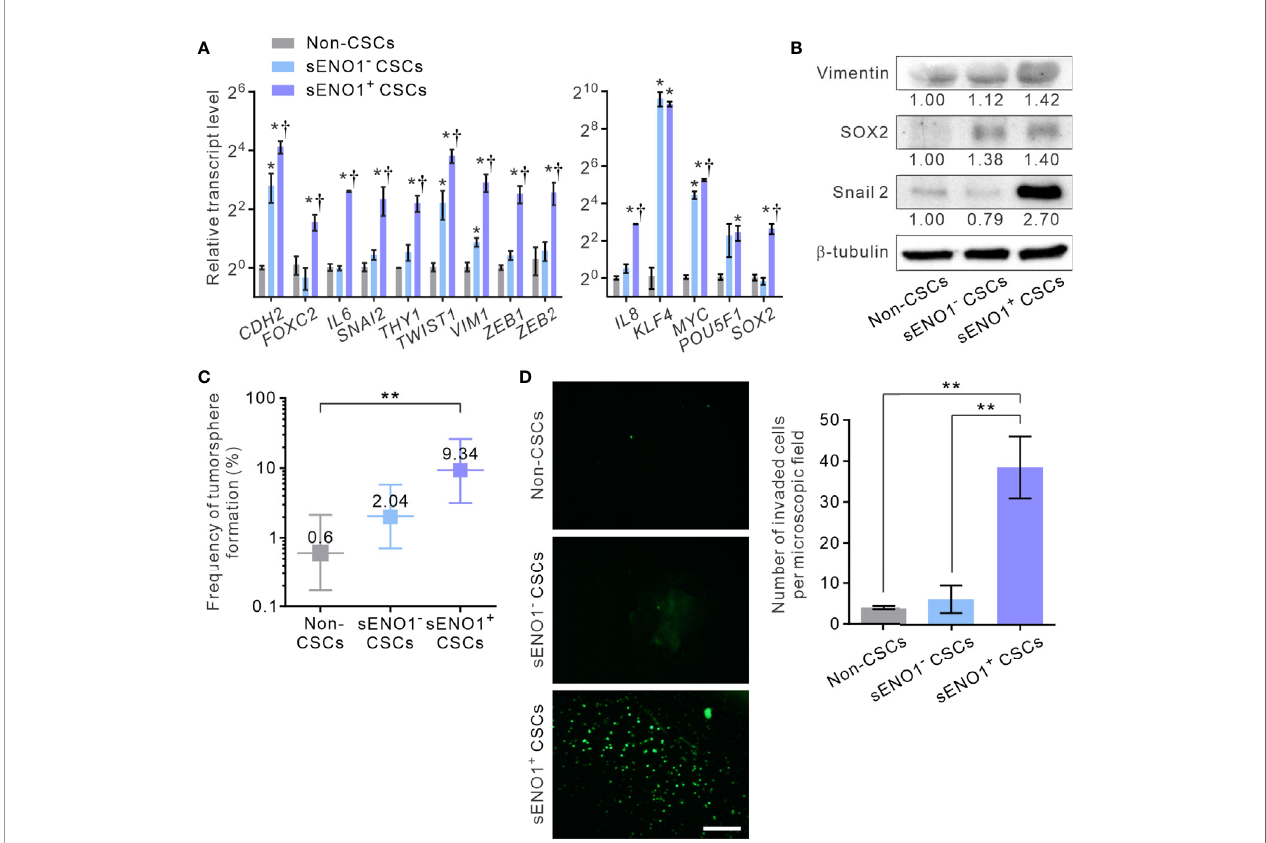
FIGURE 2 | sENO1 marks a subpopulation of mesenchymal-like and highly invasive CSCs. (A) The relative transcript levels of the mesenchymal- (left) or pluripotency- (right) associated genes in sENO1 + CSCs (represented by CD44 + CD133 + 22Rv-1 cells), sENO1 - CSCs, and non-CSCs (represented by cells in the other subpopulations) using qRT-PCR analysis. Error bars represent mean ± SEM from three independent experiments (n = 3). Unpaired t-test was performed throughout where *p < 0.05 versus non-CSCs; † p < 0.05 versus sENO1 - CSCs. (B) Immunoblotting analysis of the indicated markers selected from (A) in non- CSCs, sENO + , and sENO - CSCs. Protein levels were quanti fi ed by densitometric analysis of the bands, normalized to b -tubulin (loading control). (C) Limiting dilution assay (LDA) demonstrating the tumorsphere-forming ef fi cacy of each subset of tumor cells. Three independent experiments were performed (n = 6). Shown are maximum likelihood estimates with a 95% con fi dence interval, where **p < 0.01. (D) The invasive capacities of freshly sorted sENO1 + CSCs (represented by CD44 + CD133 + 22Rv-1 cells), sENO1 - CSCs, and non-CSCs in 22Rv-1 cells in a dual-chamber invasion assay. Shown are representative immuno fl uorescence images of the invaded cells, with cell nuclei stained with SYTOX-green (green). Scale bars = 500 µm. Right, the number of invaded cells. Error bars represent mean ± SEM from three independent experiments (n = 3). Unpaired t-test was performed throughout where **p <